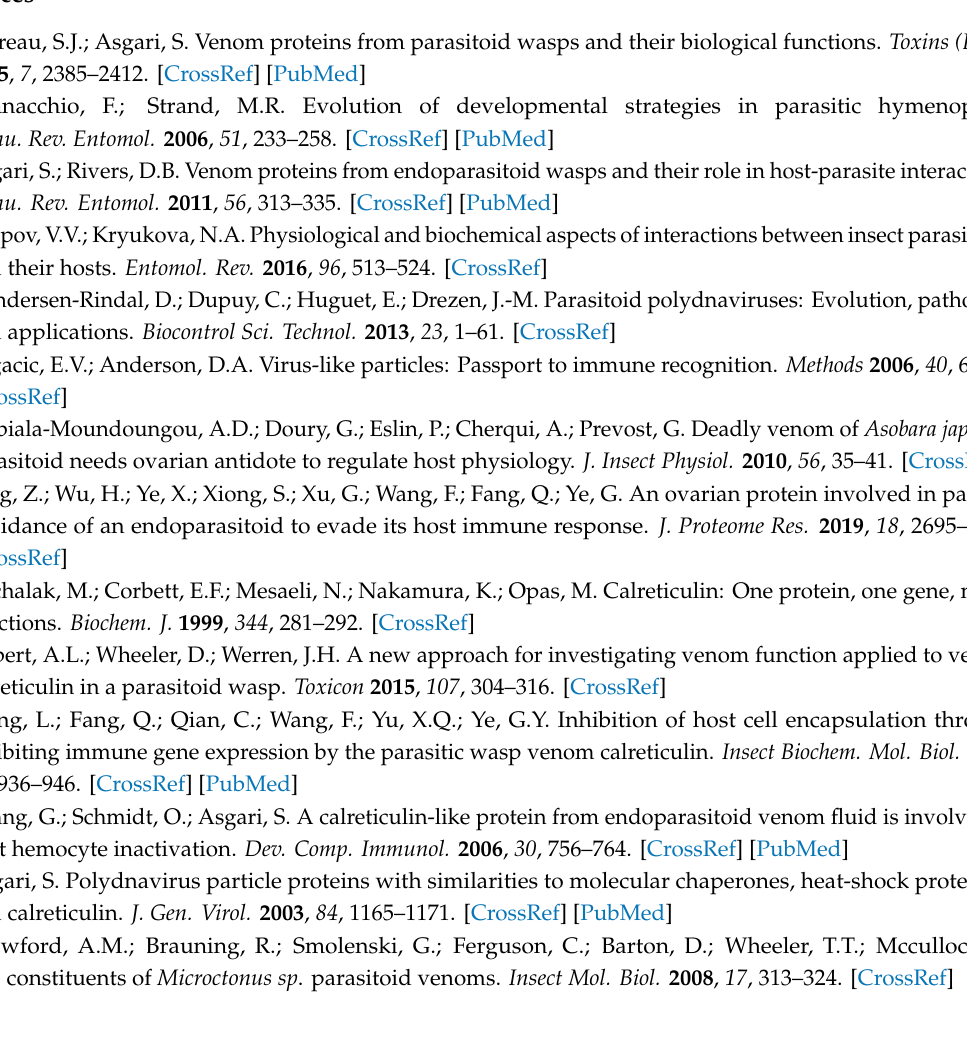
Figure S1: multiple sequence alignment between PvCRT and Drosophila CRT, Table S1: primers used in the main